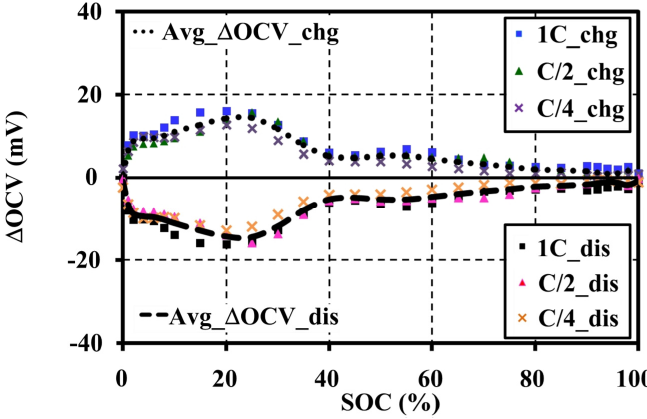
Figure 10. Zoom of the hysteresis occurrence tested at 20 °C with 60 min resting.